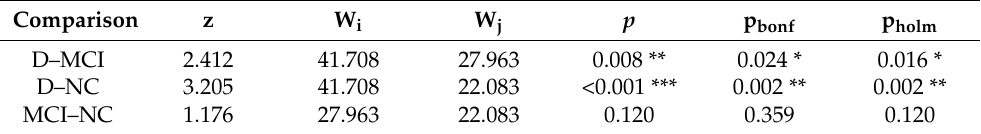
Table 9. Dunn’s Post Hoc Comparisons of Combined score between D–MCI, D–NC, and MCI–NC groups.